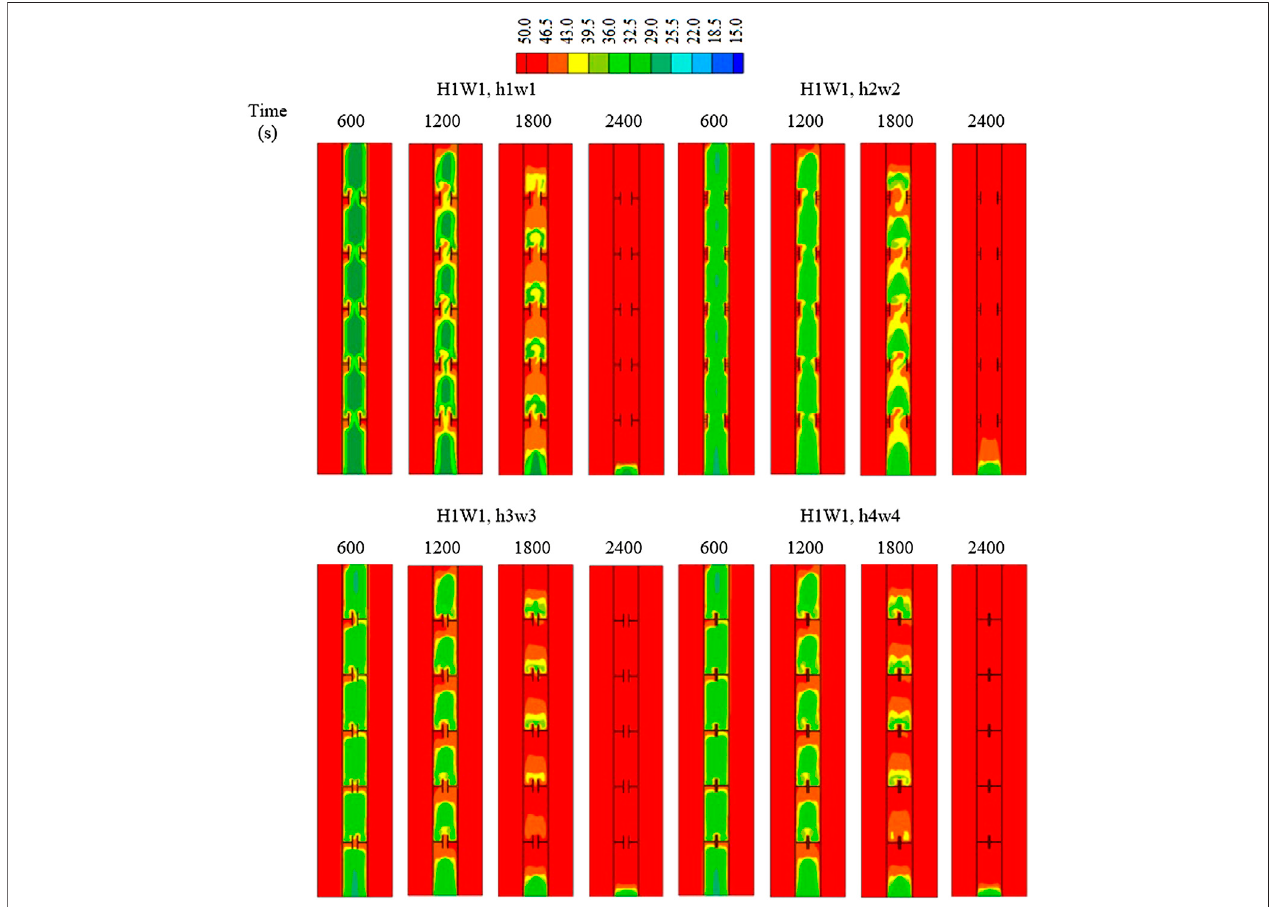
FIGURE 9 | The temperature distribution for various dimensions of the T-shaped fi n ’ s body at various times [with the same size of the fi n ’ s head (H1, W1)].